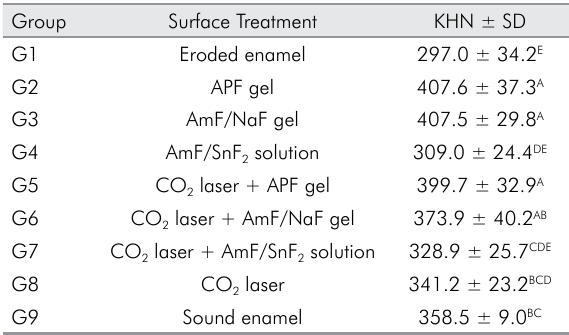
Sound enamel 358.5 ± 9.0 BC Different letters indicate statistically significant differences between rows, p <